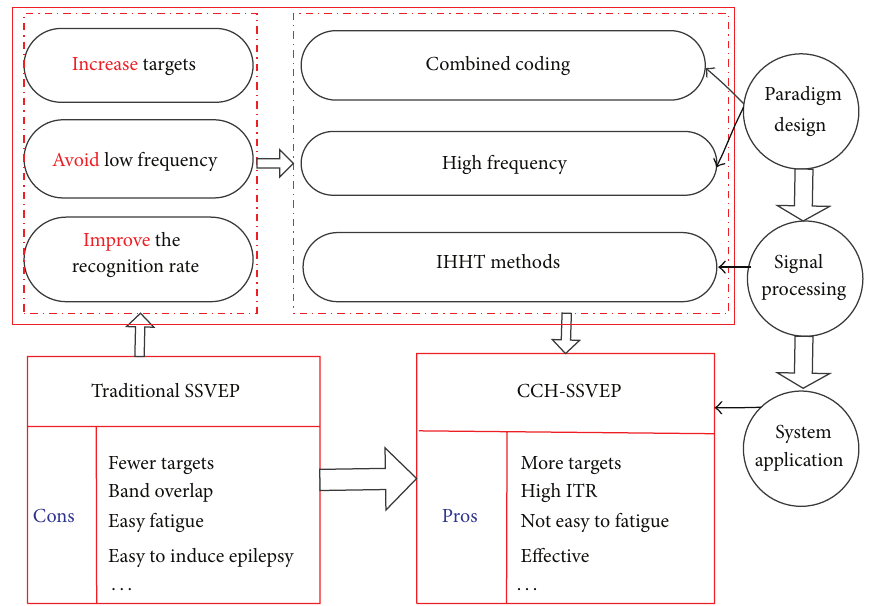
Figure 14: Advantage of HFCC-SSVEP.